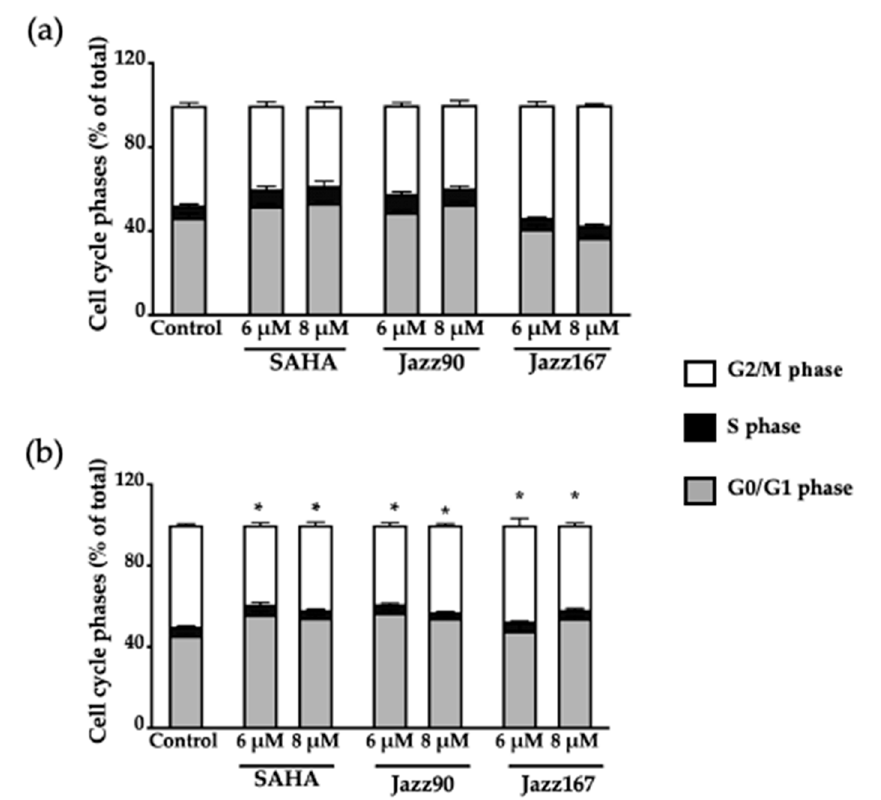
Figure 7. Cell cycle phases of DU145 cells at different time-points. DU145 cells were treated with SAHA, Jazz90 and Jazz167 at concentrations of 6 and 8 µM for ( a ) 24 and ( b ) 48 h. Vehicle control cells were treated with 0.5% DMSO. Cell cycle phases were measured using flow cytometry. Bars represent the mean ± S.E.M. of percentage of cells in each of the cell cycle phases (G 0 /G 1 , S, and G 2 /M phases) from three independent experiments. Data were analyzed using a two-way ANOVA coupled with Bonferroni’s post hoc test. * indicates G 0 /G 1 significantly different from the control, p < 0.05.